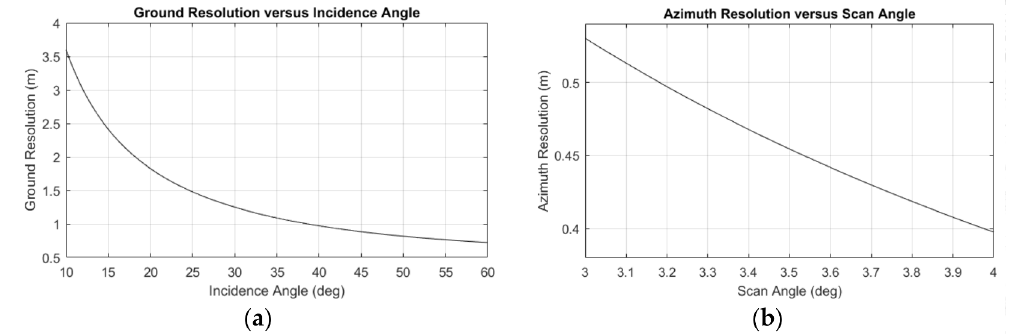
Figure 1. The resolution in ST mode. ( a ) The ground resolution versus the incidence angle; ( b ) The azimuth resolution versus the scan angle